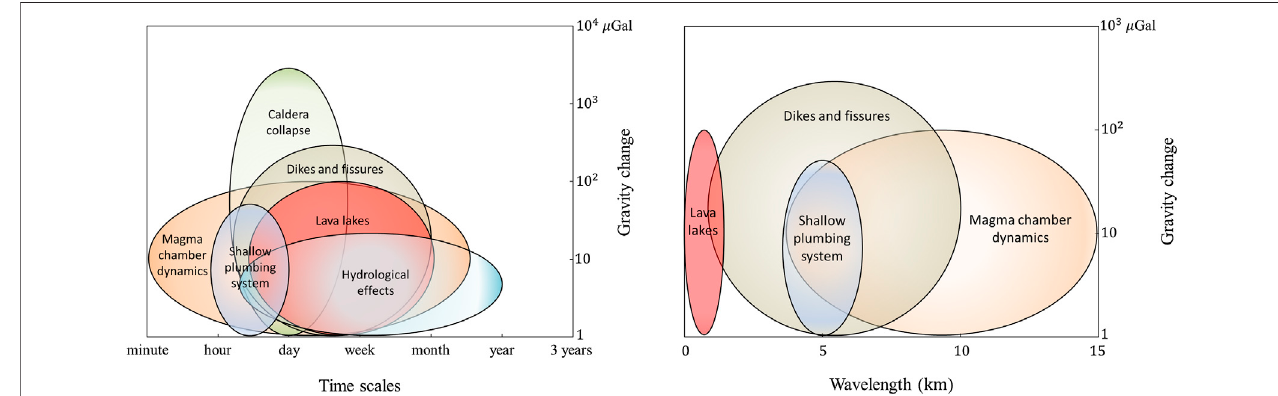
FIGURE 11 | Time (left) and space (right) scales vs. amplitude of the gravity changes induced by volcanic processes. In the left panel, the characteristics of the gravity changes induced by hydrological processes are also reported, for the sake of comparison. Conversely, “ caldera collapse ” is not reported in the right panel, since the possible space scale of this particular process covers the whole range of the x -axis of the plot and beyond.